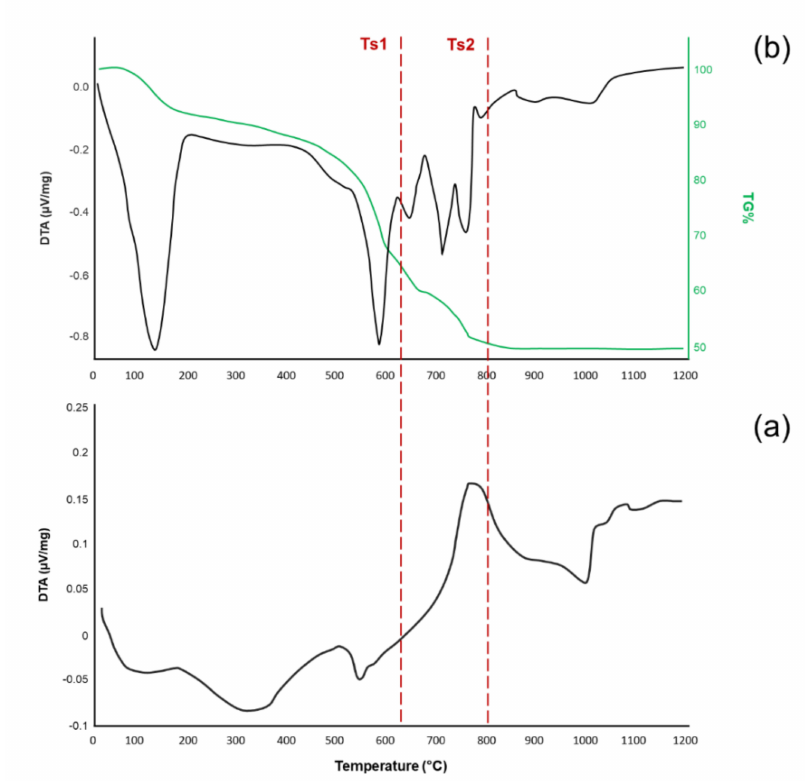
Figure 2. Thermal analysis results: DTA plot of MD-47.5B bioactive glass ( a ) and DTA-TGA plots of DG-120 sol-gel material before calcination, revealing a multi-peak trend and mass loss up to 800 ◦ C ( b